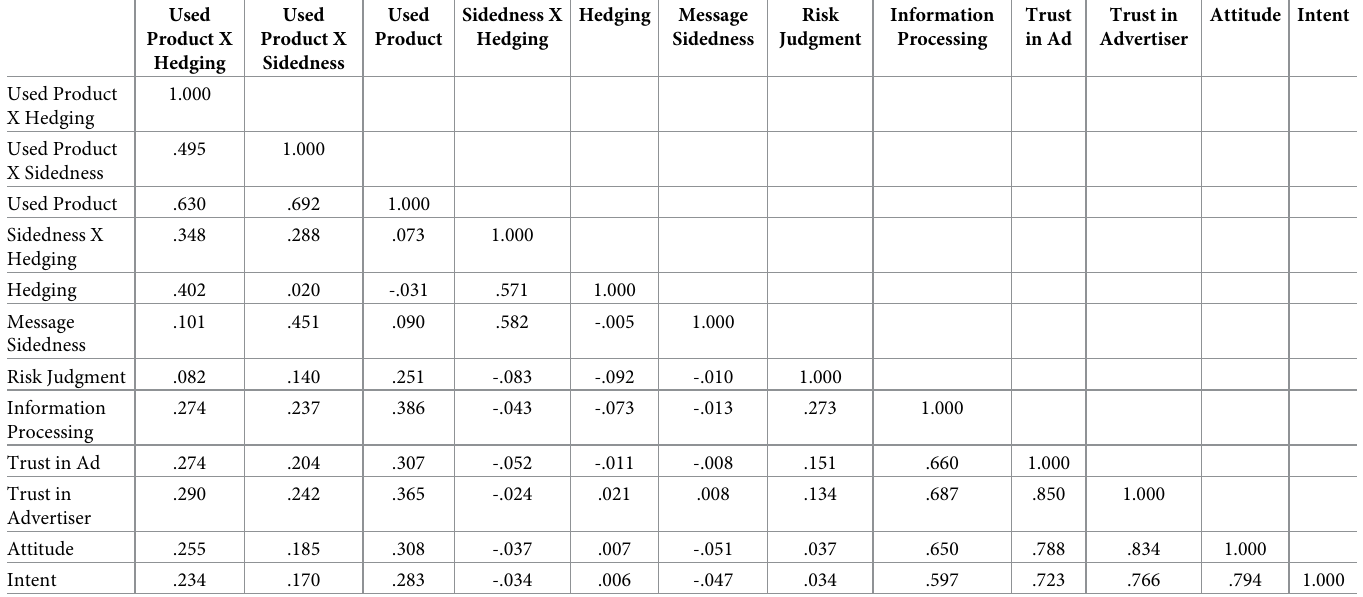
Table 4. Correlation matrix.